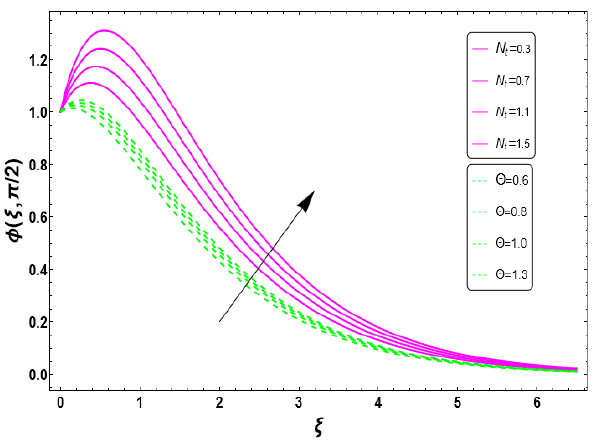
Figure 13. Profile of φ for N t and Θ Figure 13. Pro fi le of φ for t